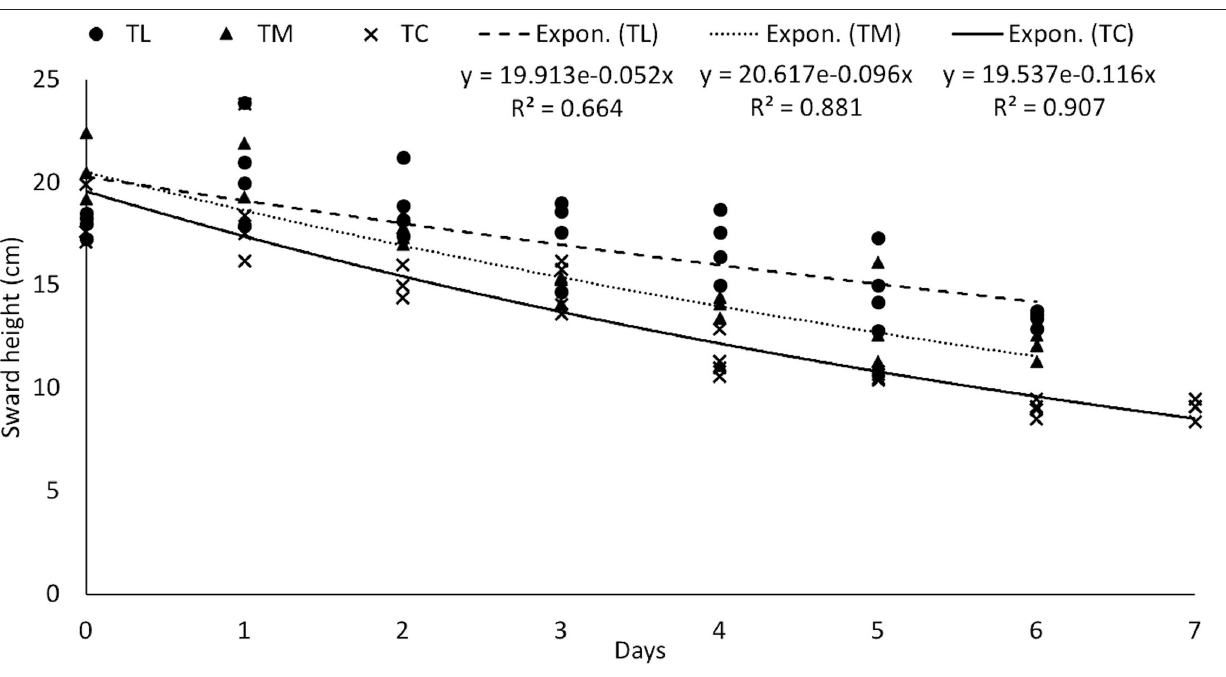
Frontiers in Animal Science |